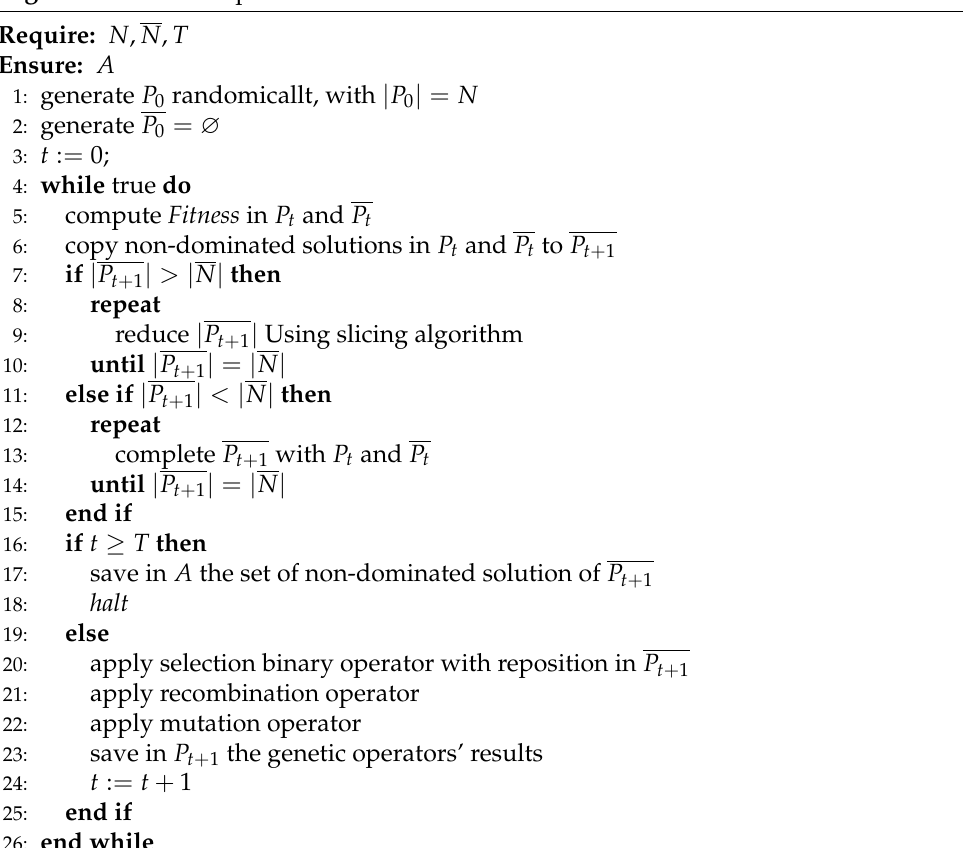
Algorithm 1 Main steps of